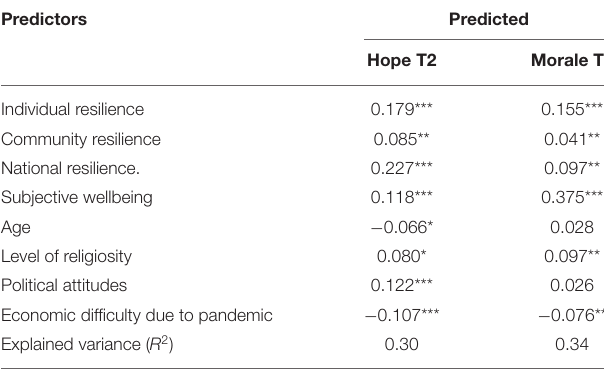
TABLE 2 | Path analysis of psychological and demographic variables at T1 predicting hope and morale at T2.